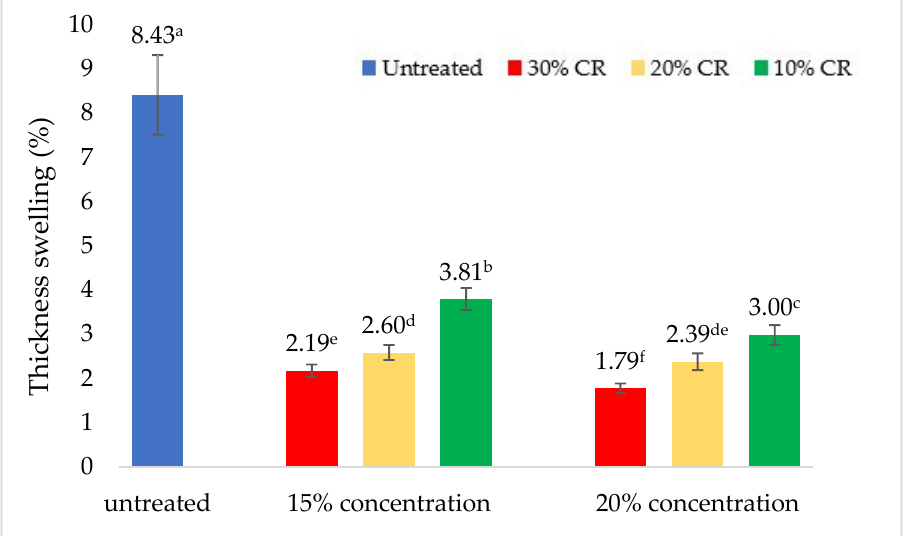
Figure 2. Thickness swelling of compreg oil palm inner wood. Note: Means followed by the same letter a, b, c, d, e is not significantly different at p ≤